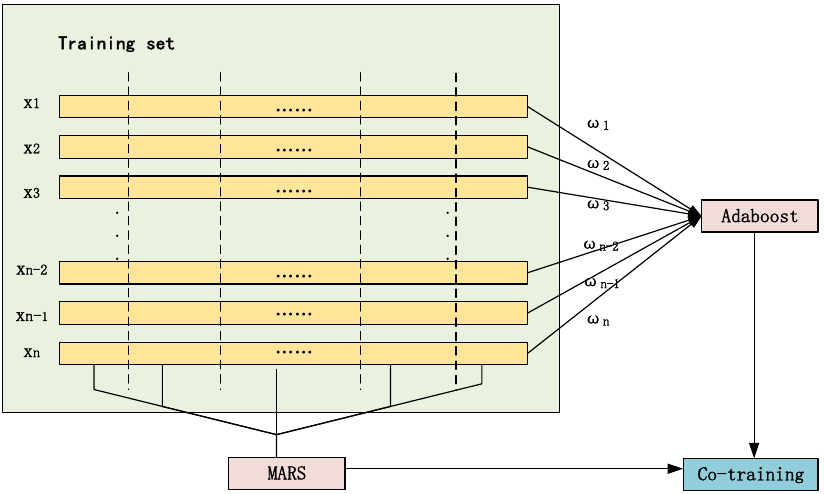
Figure 2. The strong complementarity between the multivariate adaptive regression spline (MARS) and Adaboost algorithms.